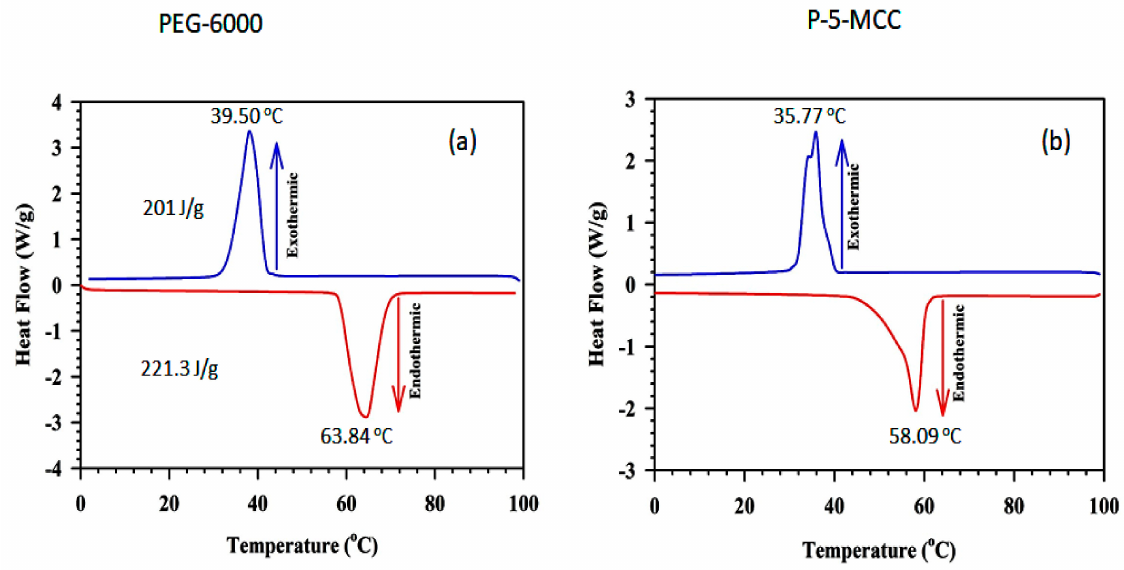
Figure 9. Melting–freezing DSC curves of ( a ) pure PEG and ( b ) P-5-MCC PCM